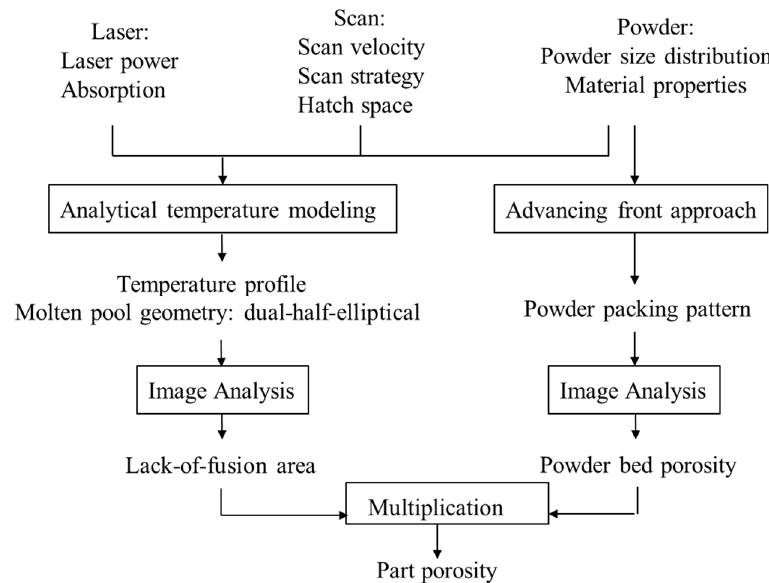
Figure 1. Algorithm for the prediction of lack-of-fusion porosity.